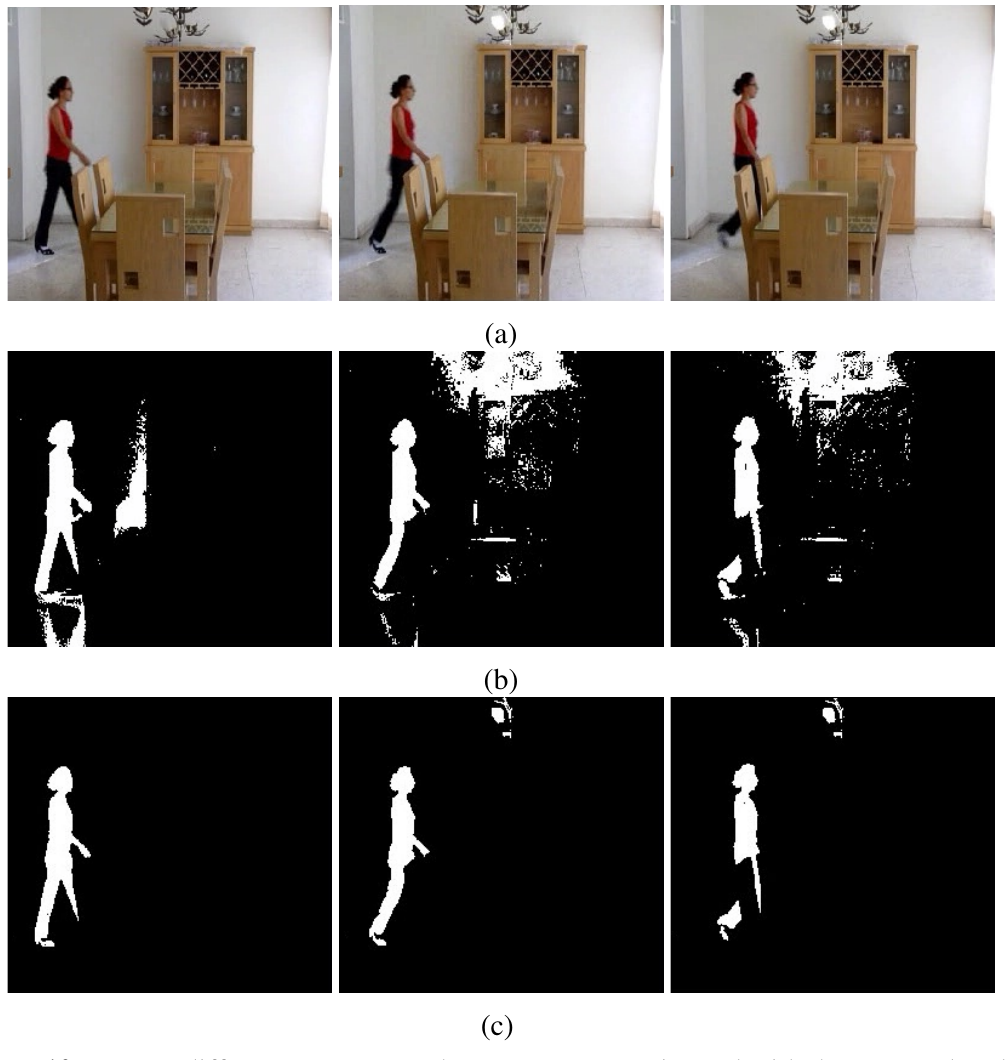
Figure 10. Images differences amongst the components estimated with the proposal and the PCA estimation. The main differences correspond to the areas affected by several lights, as the roof of the vehicles and the buildings, and, in minor sense, the global lights effects over the